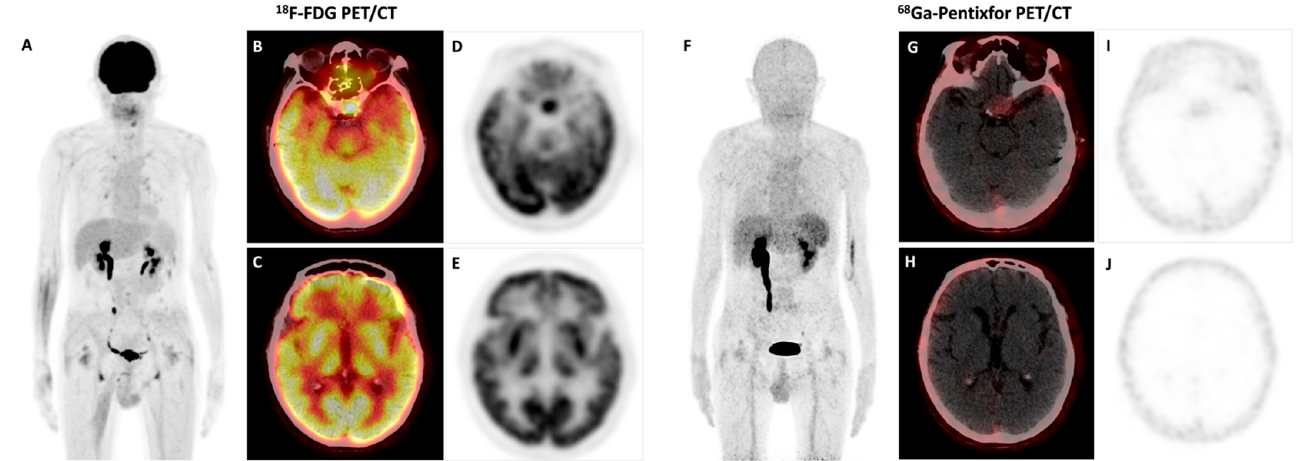
Figure 2. After six cycles of chemotherapy, the patient underwent follow-up PET/CT with both 18 F-FDG and 68 Ga-Pentixafor. MIP image of the 18 F-FDG PET ( A ), axial fusion 18 F-FDG PET/CT ( B , C ), axial 18 F-FDG PET ( D , E ), MIP image of the 68 Ga-Pentixafor PET ( F ), axial fusion 68 Ga-Pentixafor PET/CT ( G , H ), and axial 68 Ga-Pentixafor PET ( I , J ). The previous high uptake of 68 Ga-Pentixafor in the choroid plexus returned to normal. There was also a complete remission of bone marrow, lymph node, and nerve roots involvement in both 68 Ga-Pentixafor and 18 F-FDG PET/CT. However, the manifestations of the pituitary macroadenoma remained unchanged (SUVmax 11.2 in 18 F-FDG PET/CT). Bing–Neel syndrome is a rare complication involving almost 1% of WM patients [4]. About one-third of patients with Bing–Neel syndrome had symptoms of peripheral neuropathies [4,5]. Leptomeningeal infiltration was most commonly seen, followed by parenchymal and dural involvement [4,6]. Involvement in the choroid plexus is rare. MRI can be used to detect central nervous system involvement in Bing–Neel syndrome, but it lacks specificity . In a previous case report of Bing–Neel syndrome, the lesions shown in MRI were hypometabolic in 18 F-FDG PET/CT [7], which was consistent with our case. Two other cases reported FDG-avid central nervous system involvement of Bing–Neel syndrome [8,9]. 18 F-FDG showed pronounced physiological accumulations in the brain, which may omit the pathological findings. However , the physiologic uptake of 68 Ga-Pentixafor is very low in the head, resulting in excellent tumor-to-background contrast and a higher detection rate of cerebral lesions. Thus, as there is a high level of CXCR4 expression in B-cells of WM [1,10], 68 Ga-Pentixafor should be further assessed as a potential tracer for the evaluation of WM, including the involvement of the central nervous system.